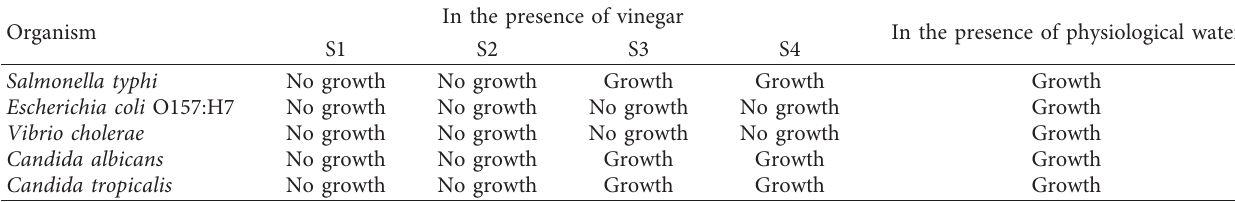
Table 3: Results of microorganisms and vinegar samples in the spread plate method.